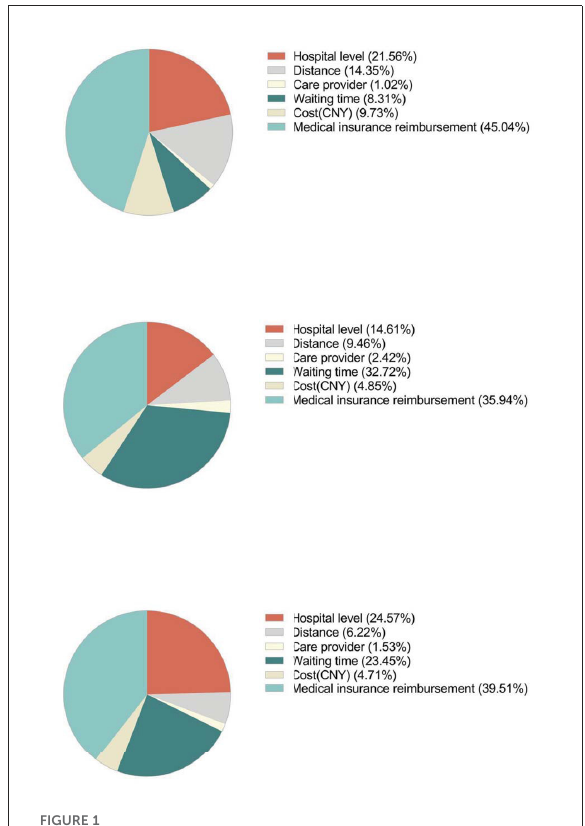
FIGURE1 Attribute importance